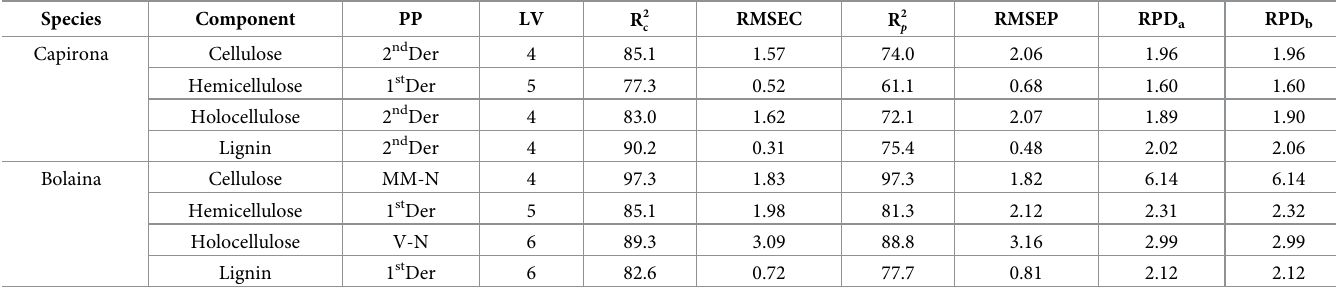
Table 3. Performance evaluation of PLS models to predict wood chemical